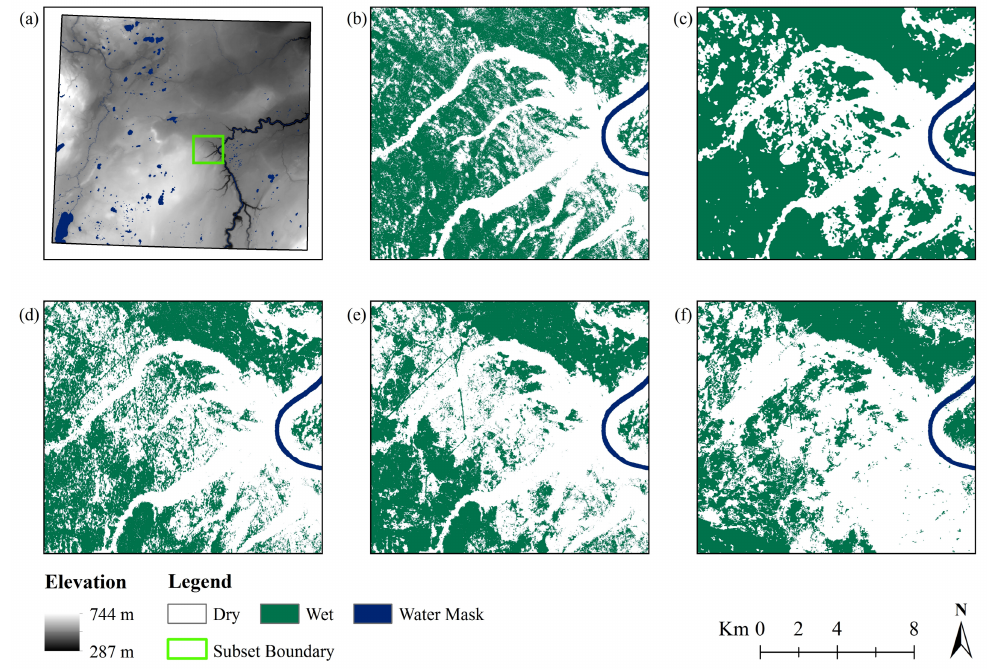
Figure 9. Local variations in wetland classification for the area located within a central subsection of the study area delineated by the green box in ( a ), for ( b ) T model , ( c ) TO model , ( d ) TS model , and ( e ) TOS model models, as well as ( f ) the